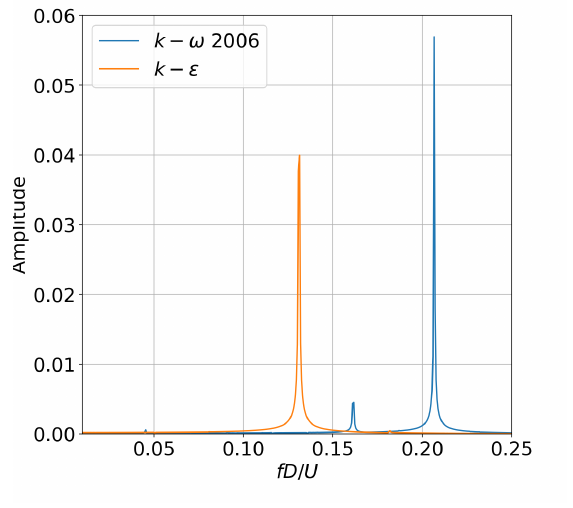
Figure A2. Spectrum of the velocity